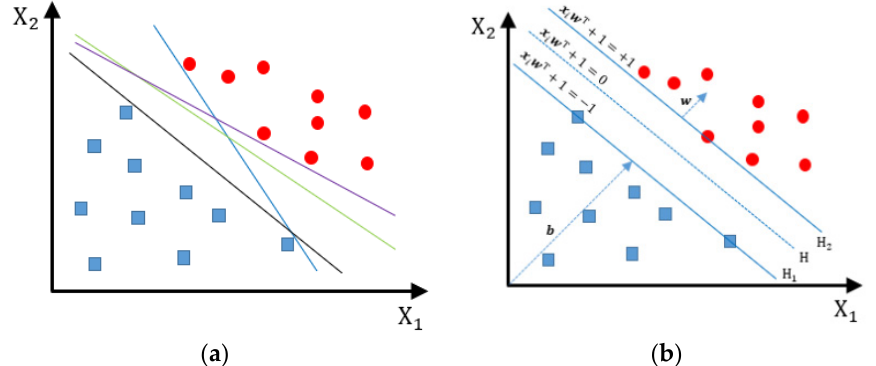
Figure 2. sketch of soft classi fi cation and nonlinear classi fi cation based on SVM. ( a ) Separation hyperplanes; ( b ) Optimal hyperplanes. Blue and red dots are data belonging to di ff erent classes.